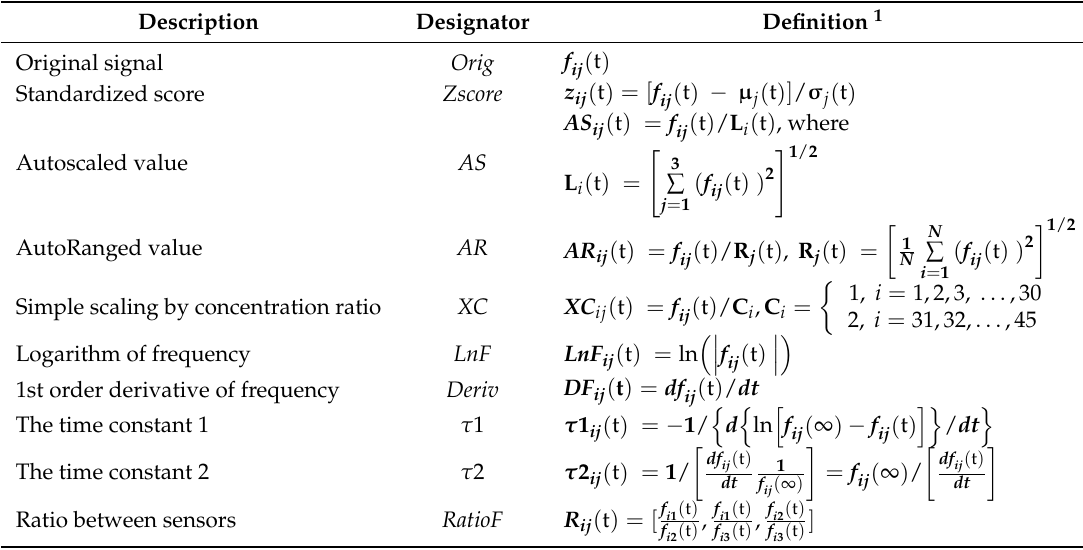
Table 2. List of extracted